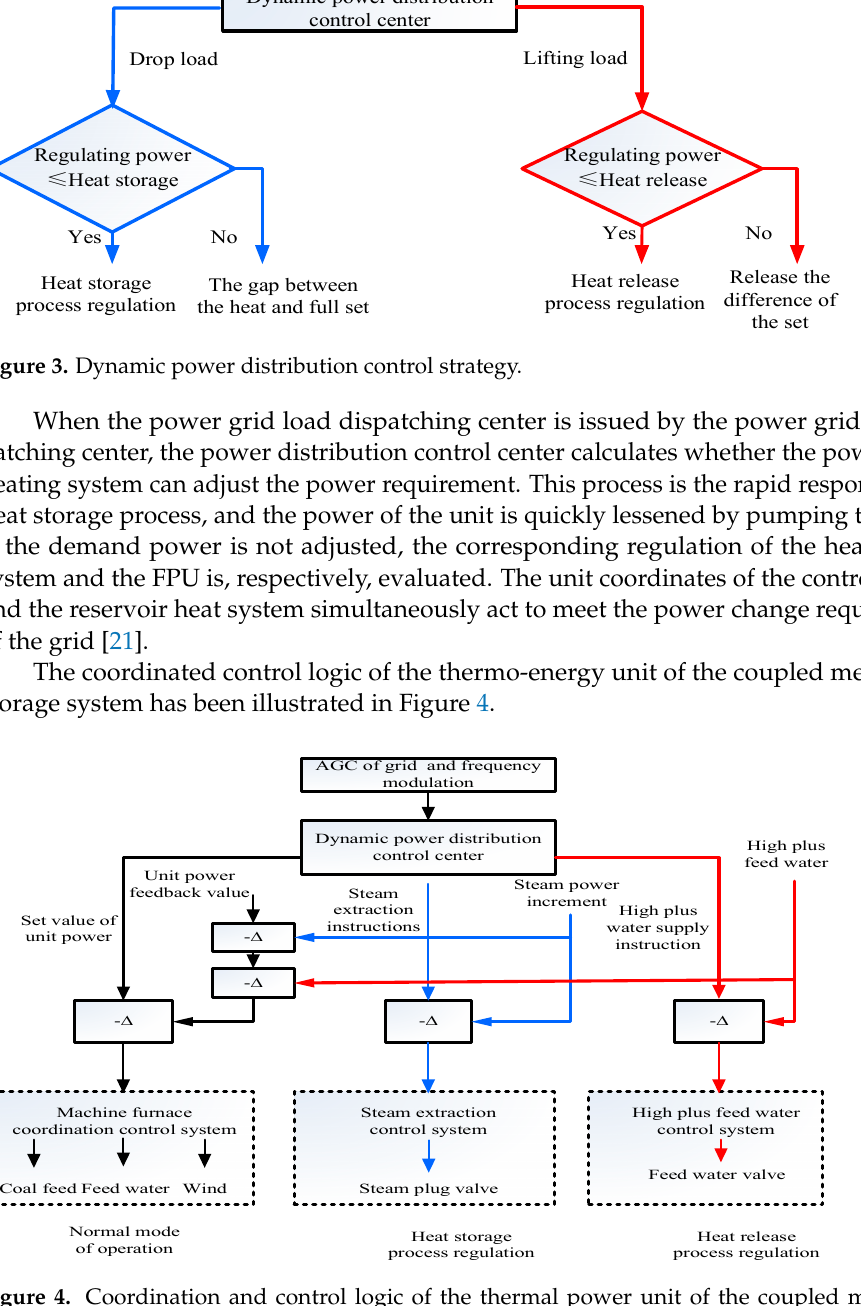
Figure 4. Coordination and control logic of the thermal power unit of the coupled molten salt storage system.